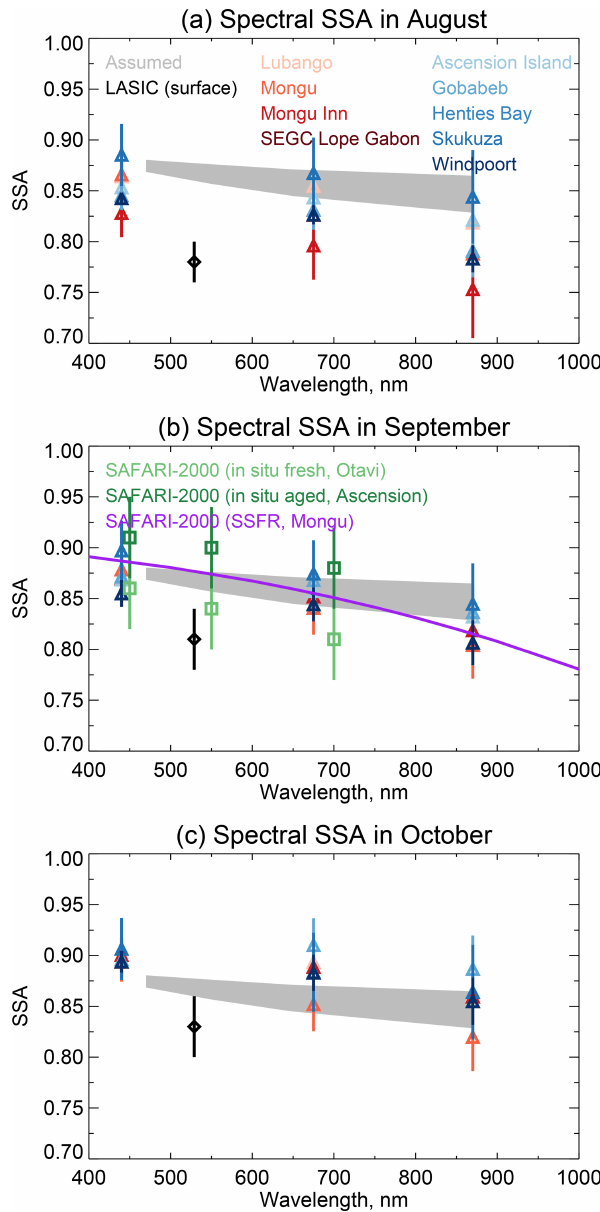
Figure 12. Relevant spectral SSA data collected in (a) August, (b) September, and (c) October. The grey shaded region indicates the range of the assumed SSA for mid-visible AOD between 0.1 and 1. Mean and standard deviation of AERONET inversions at sites which tend to sample near-source and transported smoke are shown in red and blue triangles respectively. Monthly mean and standard deviation of surface measurements during the LASIC field cam- paign, reported by Zuidema et al. (2018), are in black diamonds. Airborne in situ measurements from SAFARI-2000 reported by Haywood et al. (2003) are shown for fresh and aged smoke in light and dark green boxes, respectively; airborne remotely sensed mea- surements from SAFARI-2000 reported by Bergstrom et al. (2003) are shown in